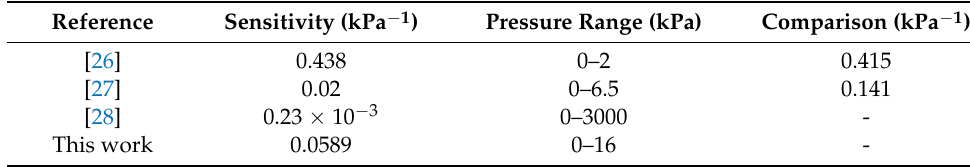
Table 9. Comparison of sensitivity based on this work and previous reports.